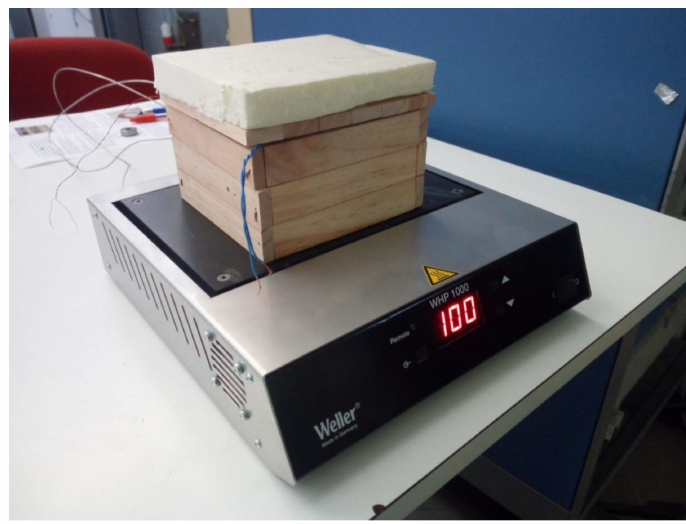
Figure 2. The heating process: chamber and heater at 100 ◦ C.